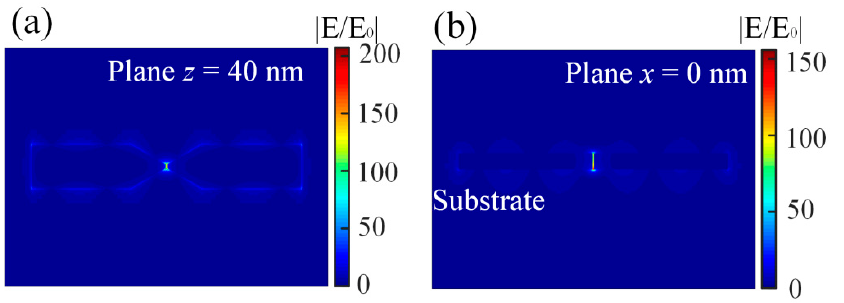
Figure 3. ( a ) The electric field distribution of the longitudinal mode on the plane z = 0 for the silver nanoantenna directly placed on the silica substrate. ( b ) The electric field distribution of the longitudinal mode on the plane x = 0 for the silver nanoantenna directly placed on the silica substrate. The color bars indicate the electric field